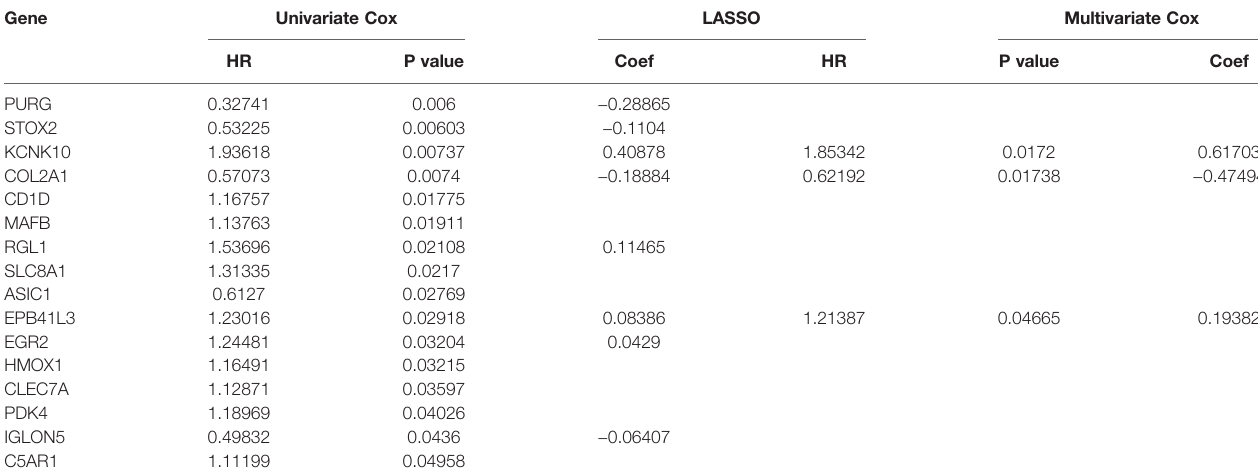
TABLE 3 | Identi fi cation of hub prognostic mRNAs through univariate Cox regression-lasso regression-multivariate Cox regression. Gene Univariate Cox